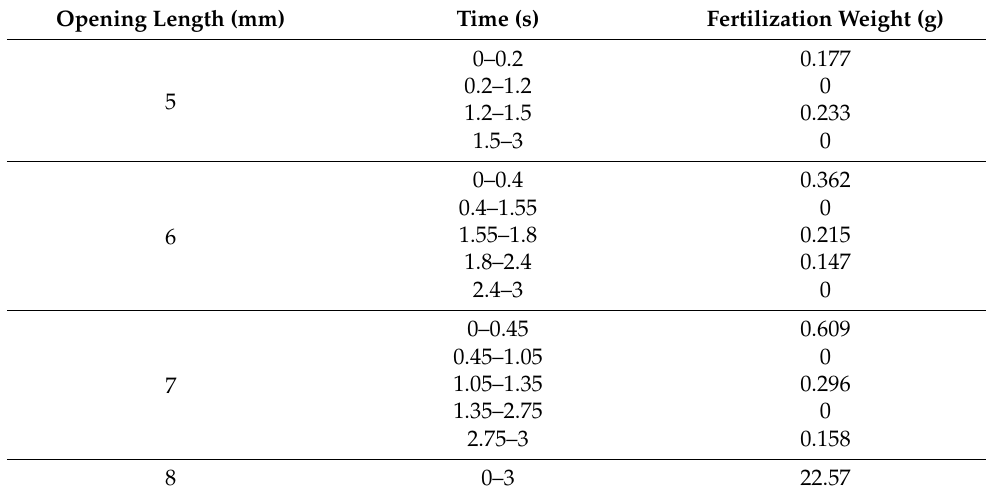
Table 5. Fertilization capability for various opening